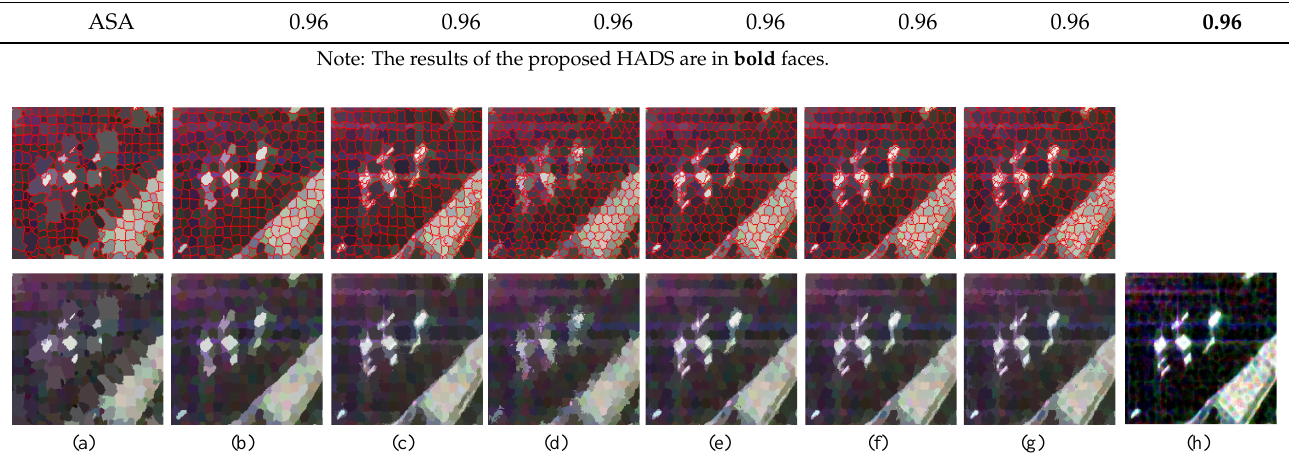
Figure 21. Enlarged results for region D of data set 5. ( a ) POL-SLIC. ( b ) POL-LSC. ( c ) POL-HLT. ( d ) HAGS. ( e ) HAWS. ( f ) HAHS. ( g ) The proposed HADS. ( h ) Unfiltered Pauli-RGB